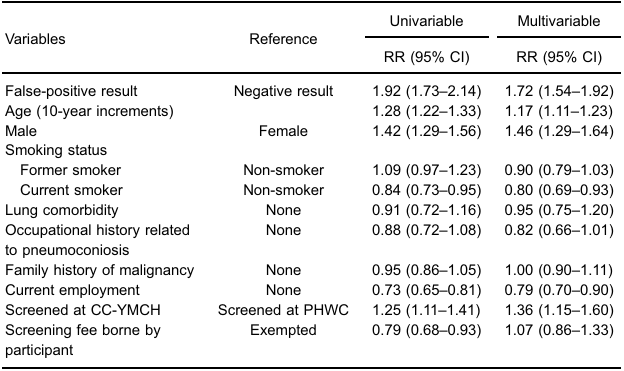
Table 3. Predictors of participation in subsequent screening based on multivariable regression analysis for participants with false-positive results